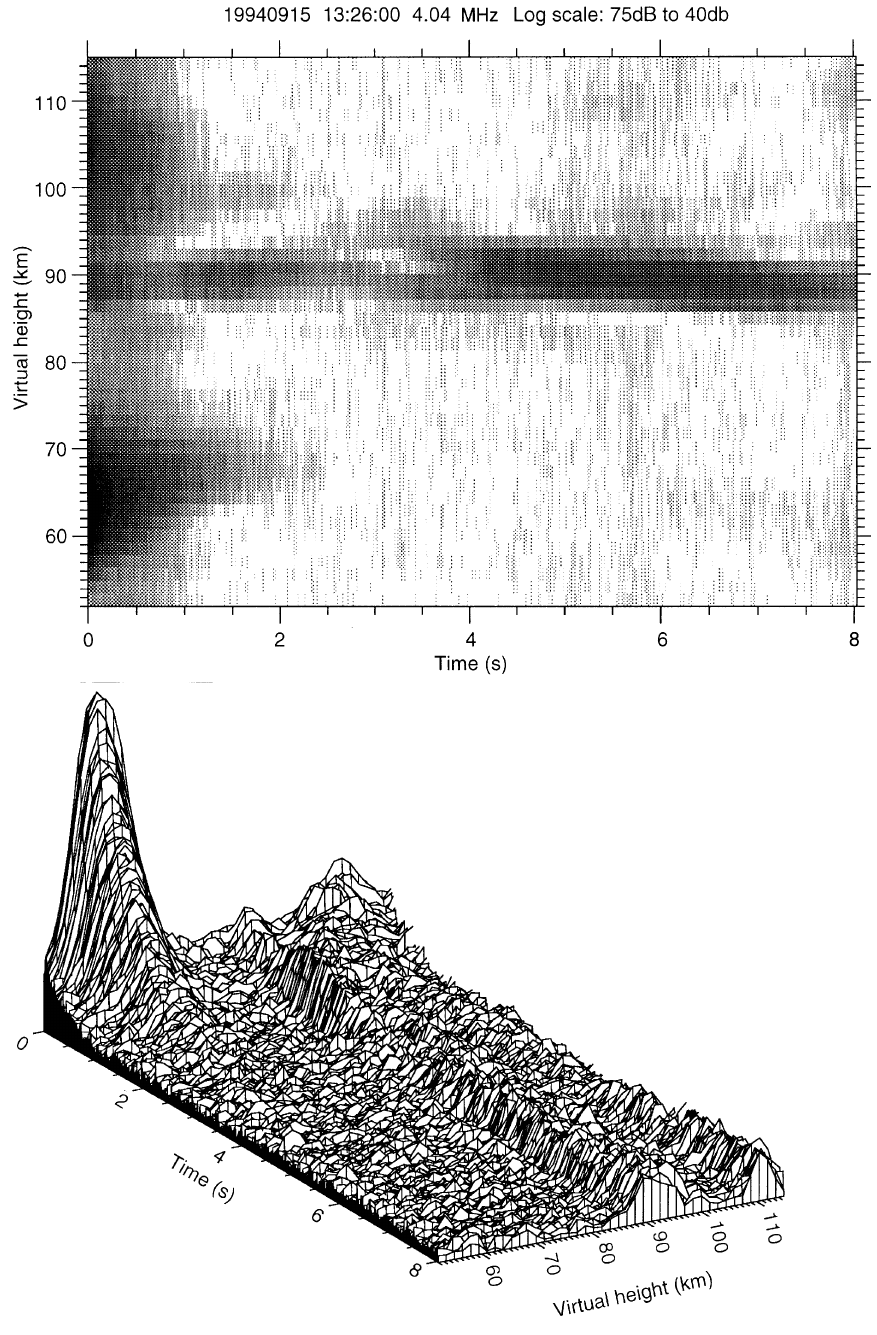
Fig. 7. Grey-scale and surface plots of API echoes extending down to 52 km on 15 September 1994. The surface plot shows linear amplitude. The pump and probing HF waves were 4.04 MHz and O-mode during these measurements. The pump had been on for 4 s prior to the 0-s tick. The weaker echoes between 85 and 95 km are thought to be natural partial